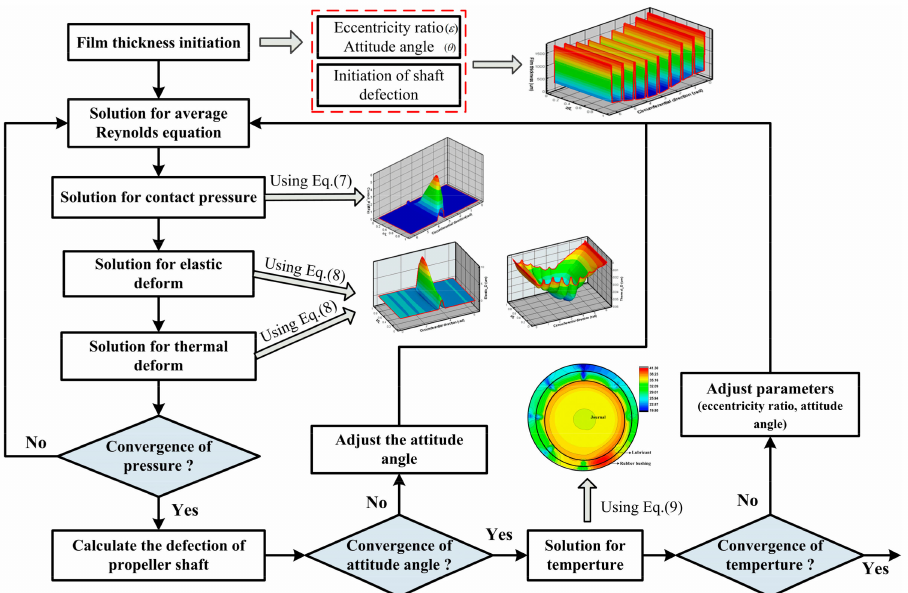
Figure 6. Flow chart for the numerical simulation process of the fluid–solid–heat (FSH) performance of the JWR system.